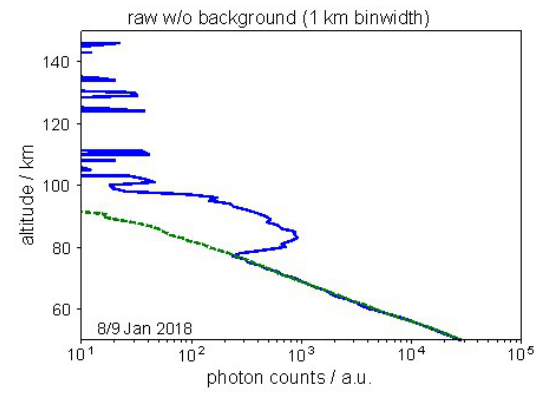
Fig. 2: Background-corrected raw data at 341 nm (blue), integrated 21-22 UTC on Jan. 8, 2018 with 1 km bin- width. The green dashed line is the 532 nm backscatter of the RMR lidar for the same